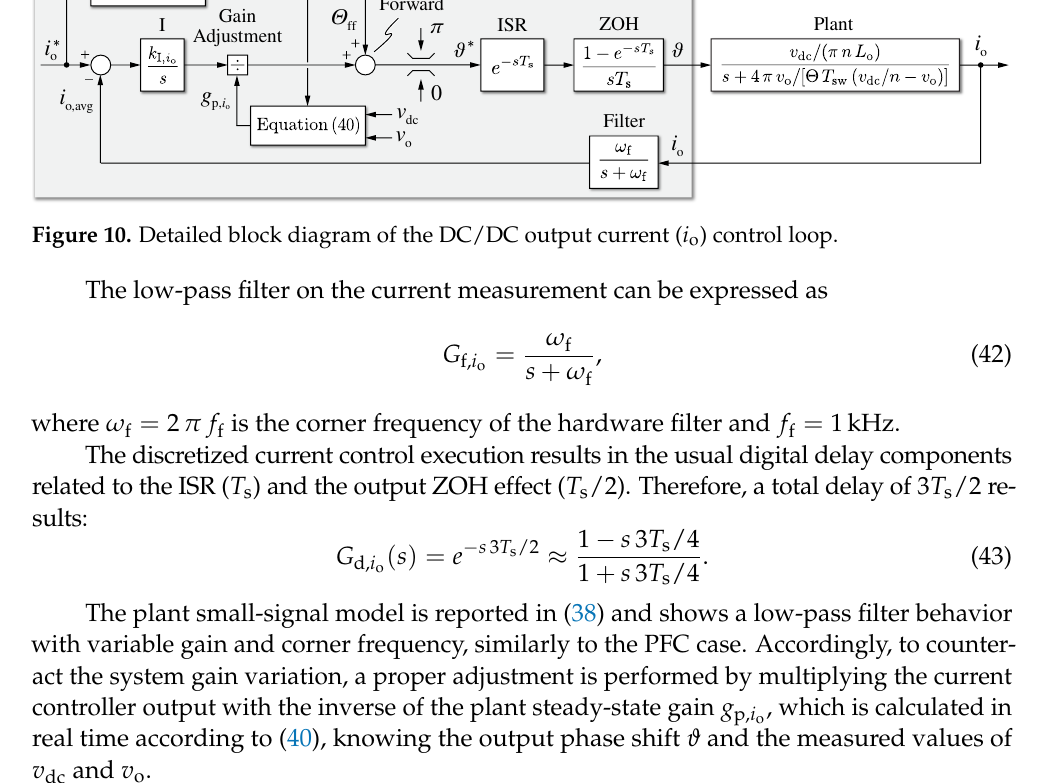
where ω f = 2 π f f is the corner frequency of the hardware filter and f f = 1